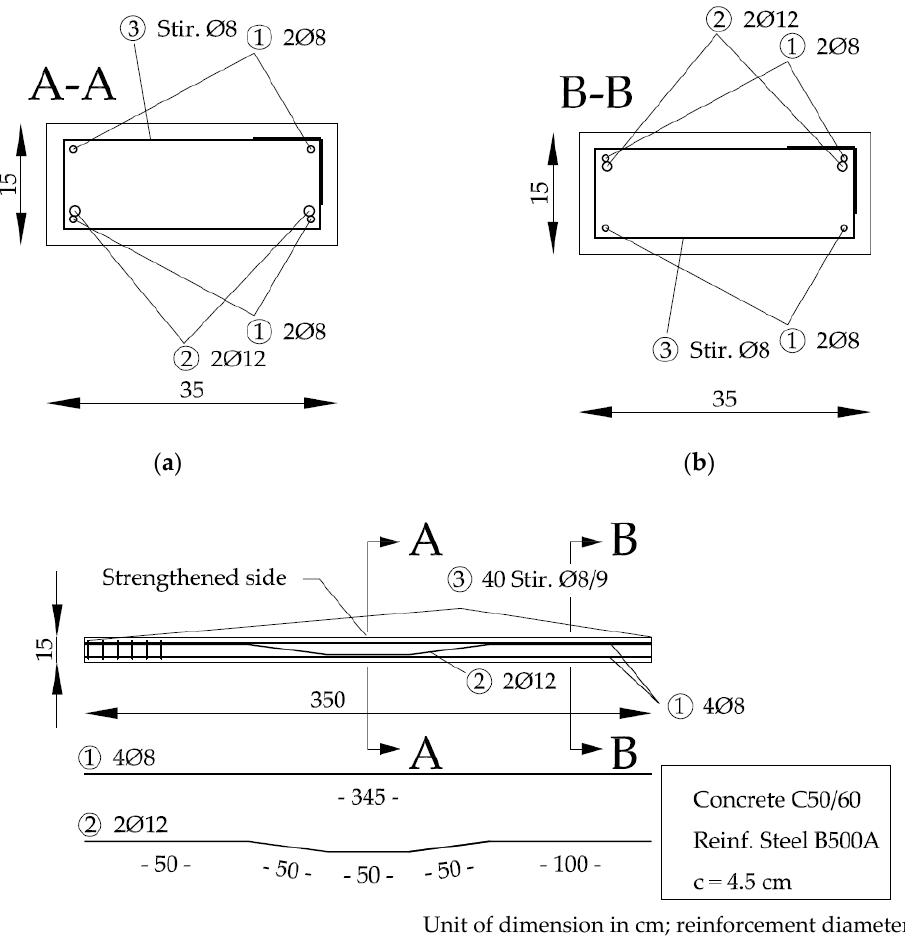
Figure 1. ( a ) Cross section of the reinforced concrete beam in the strengthened area; ( b ) Cross section of the not strengthened area of the reinforced concrete beam; ( c ) Longitudinal cut of the reinforced concrete